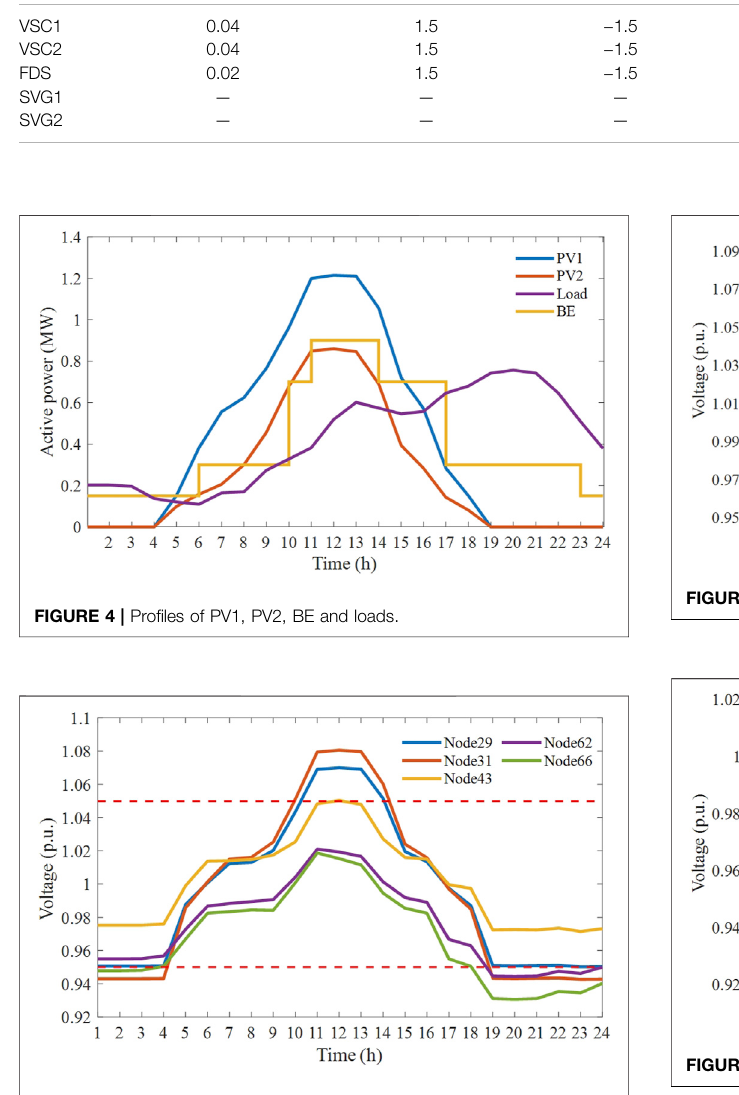
FIGURE 5 | Daily voltage pro fi le of typical nodes.